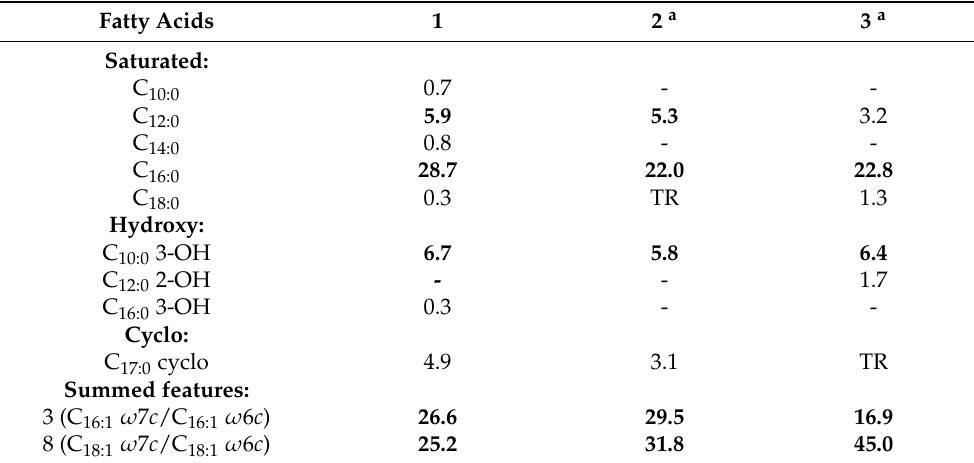
Table 2. Fatty acid profile of strain D7 T and closely related species of the genus Marinobacterium . Fatty